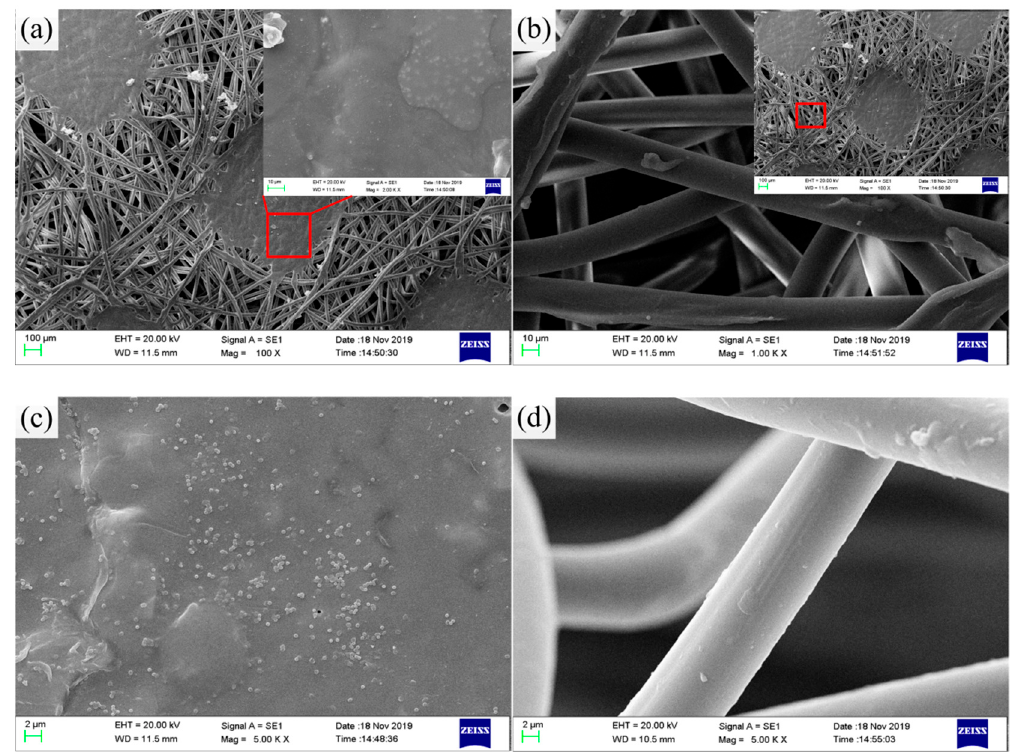
Figure 8. SEM of the composite surface: ( a ) PP non-woven at 100×; ( b ) PP non-woven at 1000×; ( c ) PP/SiO 2 /PVDF composite with 4 wt % SiO 2 and ( d ) PP/SiO 2 /PVDF (4 wt %) magnified by 5000×.